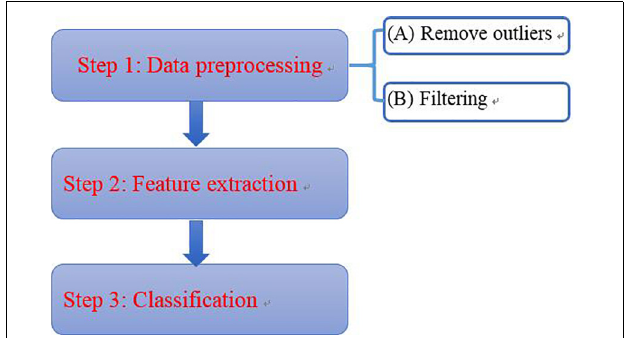
FIGURE 6 | Data processing flow.